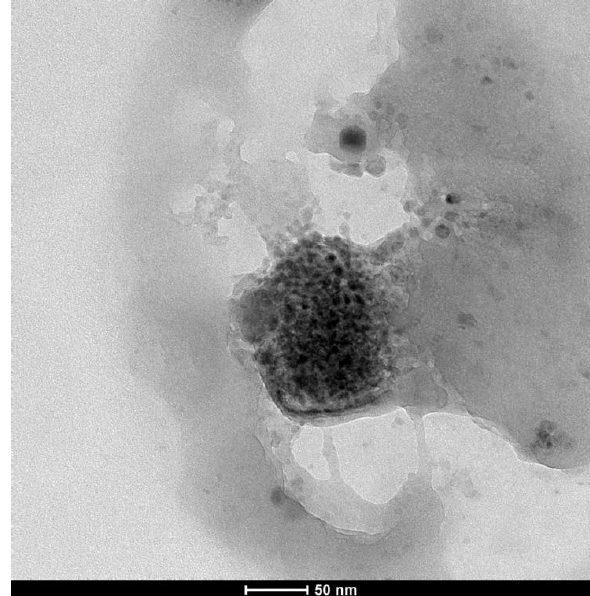
Figure 10. TEM image of an O-, S-, and Fe-containing particle ob- tained from an ascending gas flow in the soil from the Yongshengde copper deposit in northeastern Yunnan.